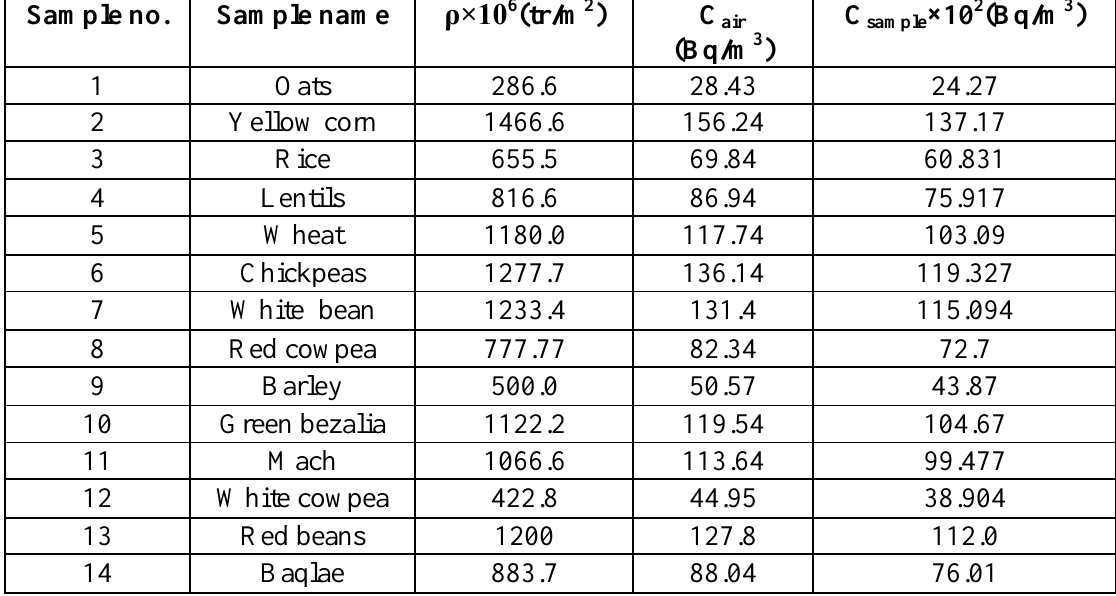
Table 1: The intensity of the effects and intensity of the radon effectiveness in the antenna space and within